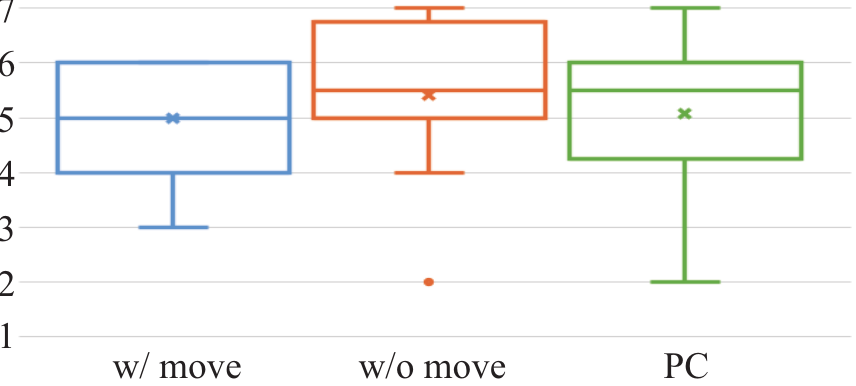
Figure 12. Results (“Did you feel that you have been to the zoo before?”).